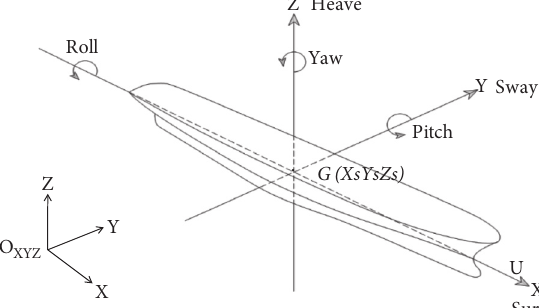
Figure 1: Schematic diagram of coordinate systems.